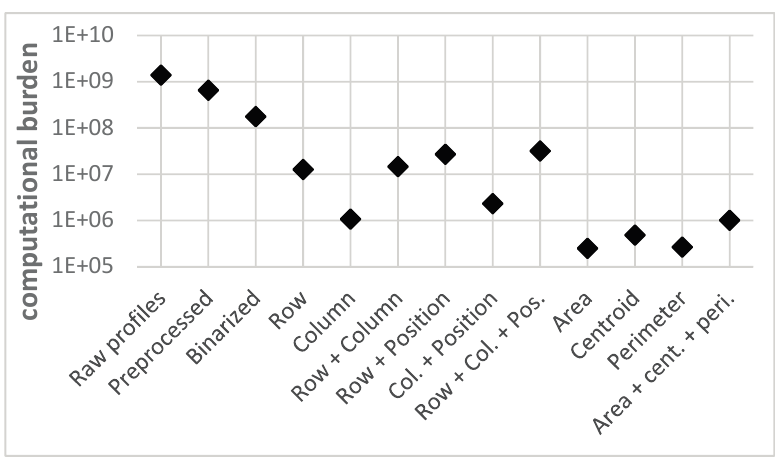
Figure 13. Classification error rates.